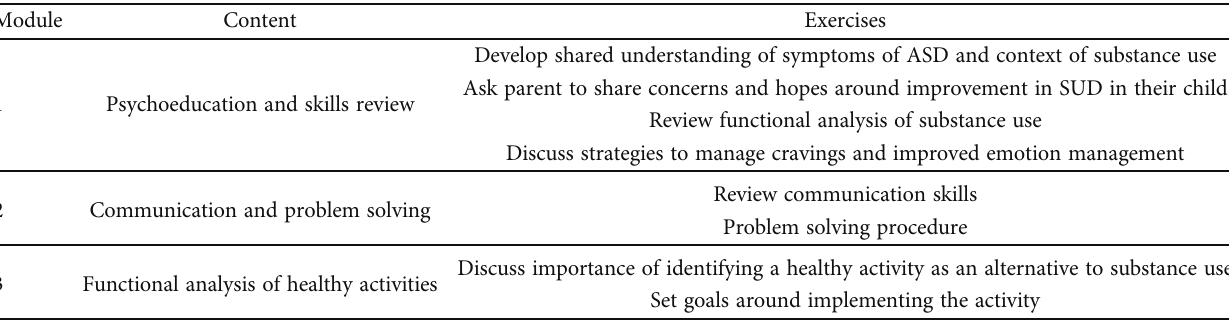
Table 3: Protocol content of joint modules youth with autism spectrum disorder (ASD) and substance use disorder (SUD), and their